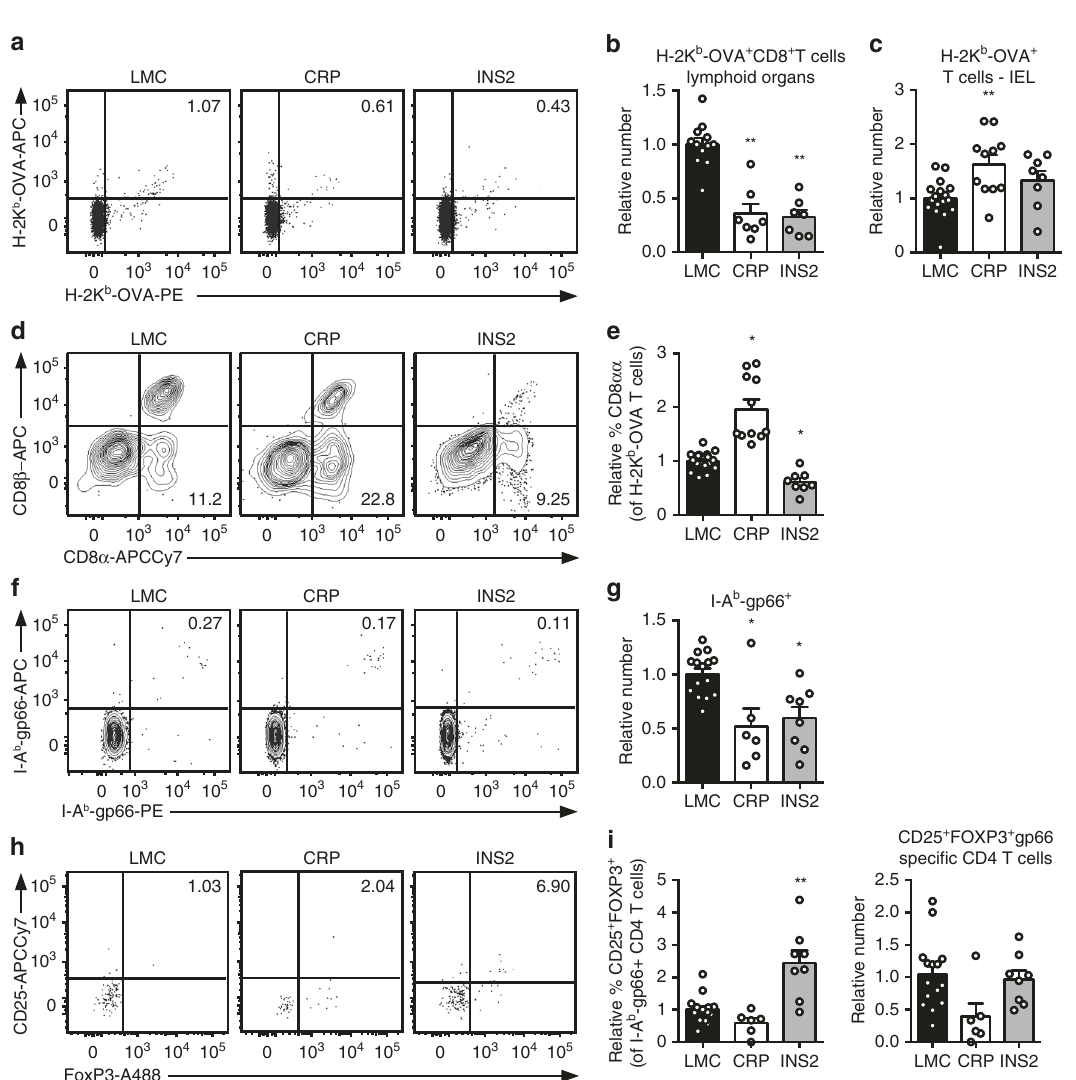
as compared to LMC, con fi rming that the decreased immune response is speci fi c to the epitopes present in the USA construct (Supplementary Fig. 5d, e). In addition, a lower proportion and absolute number of LCMV gp66-speci fi c CD4 + T cells is observed in both CRP and INS2 Tg mice after LCMV infection (Fig. 6e, f), but only the INS2 Tg mice show an increase in gp66-speci fi c CD25 + Foxp3 + T reg (Fig. 6g, h). Surprisingly, while the LCMV-OVA infected CRP lo Tg mice do not display any reduction in the gp66-speci fi c CD4 + T cells response, the INS2 lo Tg mice have reduced gp66-speci fi c CD4 + T cells of